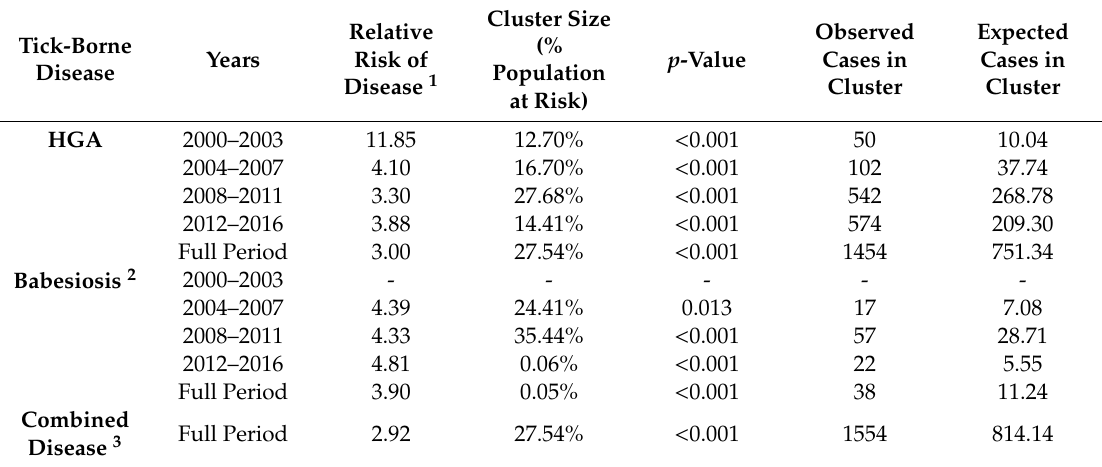
Figure 5. County level incidence for positive laboratory cases of ( A ) human granulocytic anaplasmosis (HGA), ( B ) babesiosis, ( C ) ehrlichiosis, and ( D ) all diseases combined per 100,000 patients in 2000–2016. The red line denotes primary spatial clusters. Spatial clusters were not calculated for ehrlichiosis due to small numbers of cases ( n = 15). Table 2. Summary of non-Lyme tick-borne disease risk within spatial clusters across north central Wisconsin stratified by